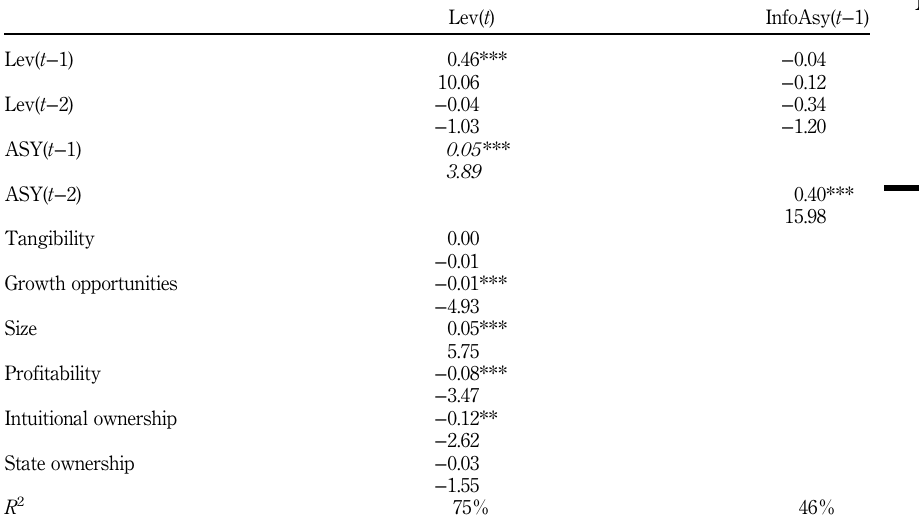
Table VI. Simultaneous equations: determinants